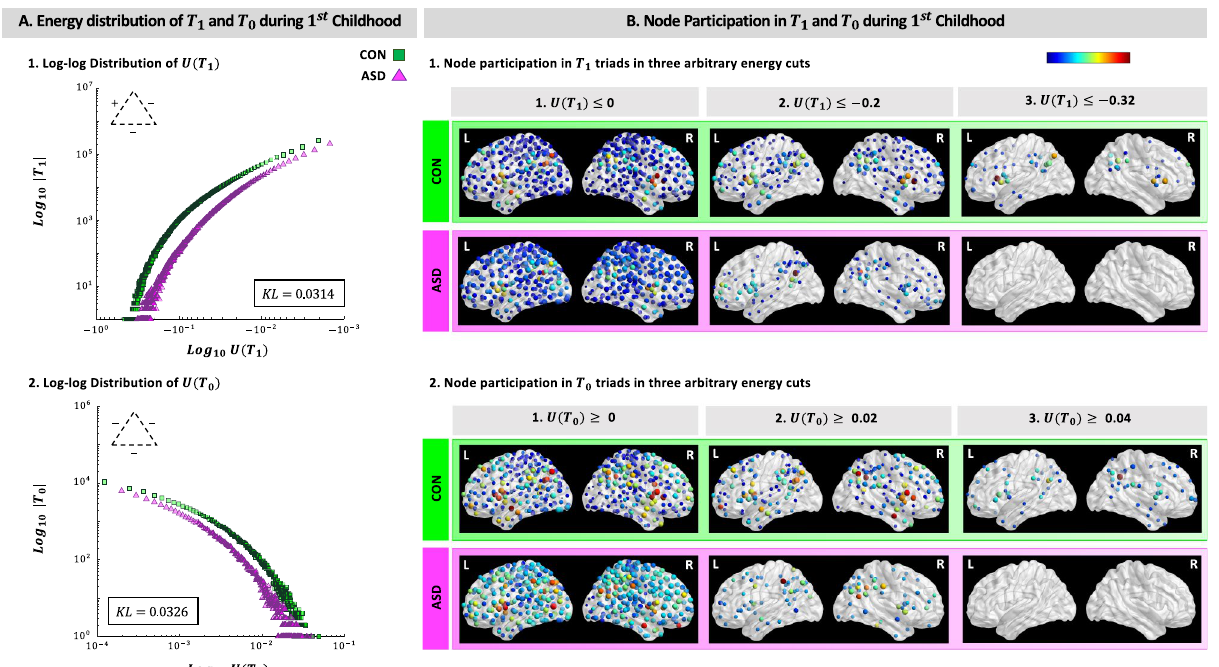
Figure 2. Energy distributions and node participation in T 1 and T 0 triads during 1st childhood. ( A ) The energy distributions of ASD group (purple/dark triangles) lag behind CON group (green/light squares) for T 1 (A.1) and T 0 (A.2) triads during 1st childhood. ( B ) For both triads we have observed a threshold above which node participation is zero for the brain network of ASD group, yet nonzero for CON group (B.1.3 for T 1 and B.2.3 for T 0 ). A detailed version of B.1.3 and B.2.3 with regions of interest’s labels is provided in the Supplementary Fig. S2. BrainNet Viewer 1.63 40 (https ://www.nitrc .org/proje cts/bnv) has been used for visualization of the brain networks. | T i | , total number of T i ; U ( T i ) , the energy of T i ; KL, the Kullback–Leiber divergence; CON, control; ASD, autism spectrum disorder (Color hand ( U ( 20, 18 ) = 101.00, z = − 2.31, p = 0.02 ) are both practically significant (η 2 = 0.14 ) . Dur- ing 2nd childhood, while there is a medium difference (η 2 = 0.10 ) in the mean frequency of positive links ( U ( 52, 52 ) = 1853.00, z = 3.25, p = 0.001 ) , there is a large difference (η 2 = 0.39 ) in the mean fre- quency of T 2 triads ( U ( 52, 52 ) = 2338.00, z = 6.41, p < 0.001 ) . Additionally, there is also a medium differ- ence (η 2 = 0.10 ) in the mean frequency of T 3 triads between ASD and CON groups during 2nd childhood ( U ( 52, 52 ) = 1868.00, z = 3.35, p = 0.001 ) . Similarly, for adolescents although there is a significant difference for both types of links (for positive links: U ( 58, 58 ) = 1181.50, z = − 2.76, p = 0.006 and for negative links: U ( 58, 58 ) = 1010.00, z = − 3.71, p < 0.001 ) , yet both of these differences are medium, η 2 = 0.06 and η 2 = 0.12 for positive and negative links, respectively. However, surprisingly for T 2 triads the difference is far more bigger than both types of links ( U ( 58, 58 ) = 162.00, z = − 8.39, p < 0.001, η 2 = 0.60 ) . There is also a big difference (η 2 = 0.23 ) in the mean frequency of T 1 triads ( U ( 58, 58 ) = 745.00, z = − 5.17, p < 0.001 ) . Additionally, there is a medium difference (η 2 = 0.09 ) in the mean frequency of T 0 triads ( U ( 58, 58 ) = 1102.00, z = − 3.20, p = 0.001 ) , and a small difference (η 2 = 0.04 ) in the mean frequency of T 3 triads ( U ( 58, 58 ) = 1270.00, z = − 2.27, p = 0.02 ) . Energy distribution of triads. After studying the frequency of triads in the brain networks of ASD and CON groups, we have explored the energy distributions of different types of triads. To this aim, we have calcu- lated the energy of triads, U ( T i ) , as shown in Fig. 6, and then for each group in three age ranges outlined the cor- responding distributions. As results indicate (Supplementary Fig. S1), for all types of triads the brain networks of ASD and CON groups have many triads with small energies and a few with considerable energies. Further- more, results of comparisons between energy distributions of triads in ASD and CON groups show that during 1st childhood the pattern of energy distributions differs between the two groups for T 1 and T 0 triads (Fig. 2A). That is, looking at the energy distributions of these two triads in ASD group (purple/dark triangles) compare to CON group (green/ light squares) it is clear that the energy distributions in ASD group lag behind distributions as they are in CON group ( KL = 0.03 , for both types). For other types of triads and during 2nd childhood and adolescence we have not observed such a lag (Supplementary Fig. S1). To better clarify this lag, for each T i we have investigated node participation which for any given node speci- fies: (1) In how many T i this node has participated? and (2) How big are the energies of those T i s? In Fig. 2B and Supplementary Fig. S2, we have addressed the former question with size of a given node and the latter with its color, which is a color-map from blue to red that respectively corresponds to the minimum and maximum levels of triads’ energy. For example, a big blue node is present in many T i s which are small in terms of energy. On the other hand, a small red node although lives in just a few T i s but in those that are important in terms of energy